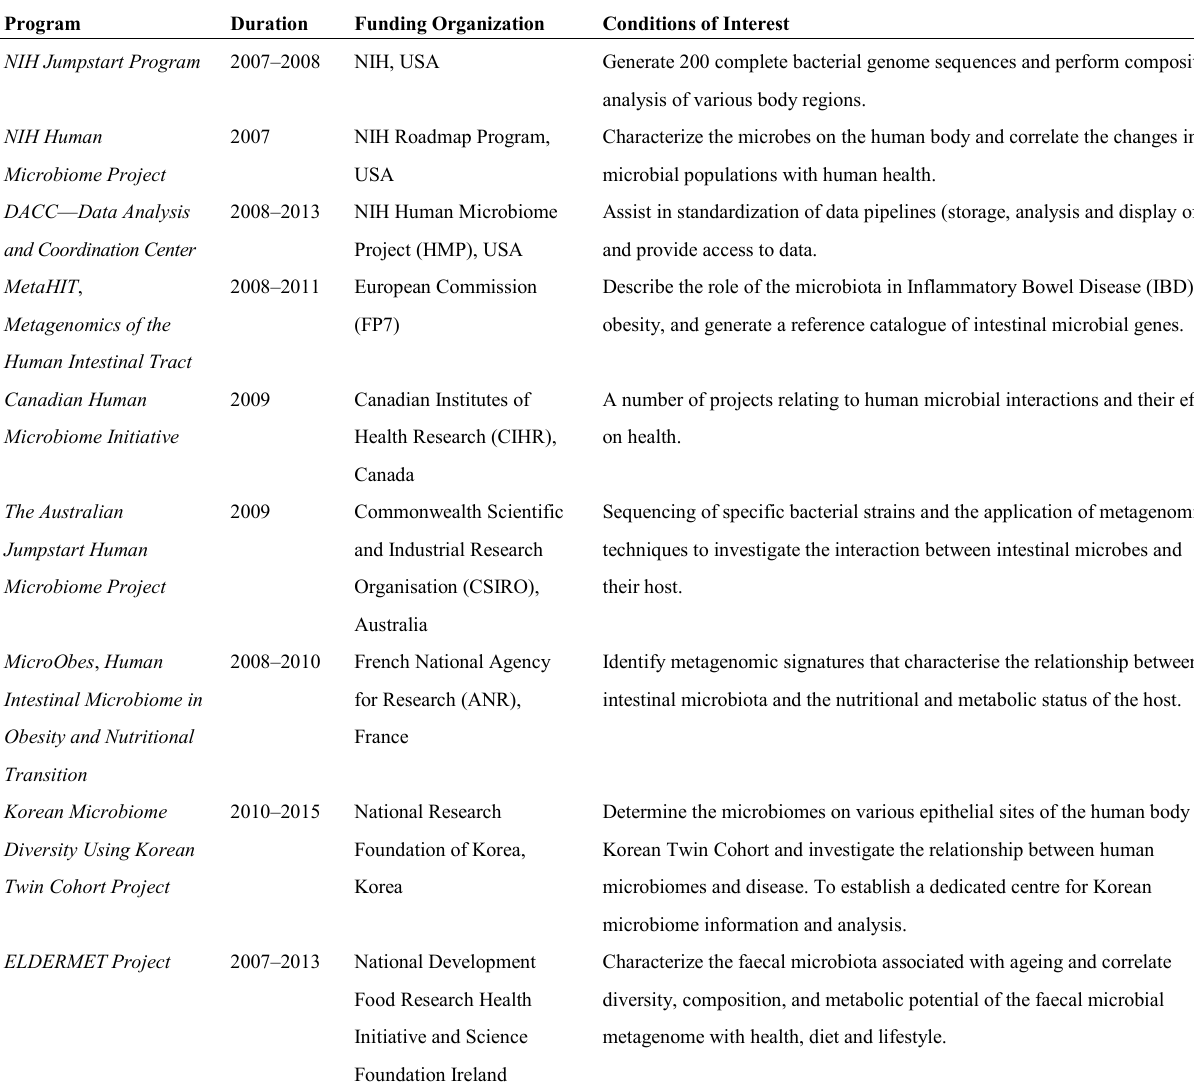
Table 1. Microbiome